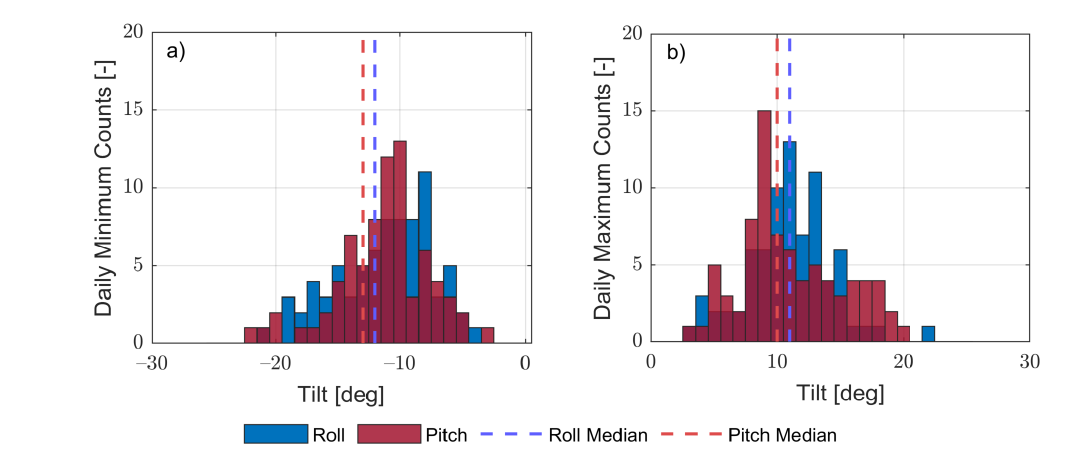
Figure 6. Histograms of the daily minimal and maximal roll and pitch inertial-measurement-unit (IMU) records (57,520,000 records between 29 Match and 17 June): ( a ) daily minimal tilt-record histogram and ( b ) daily maximal tilt-record histogram. The dashed lines represent roll (blue) and pitch (red) medians in both